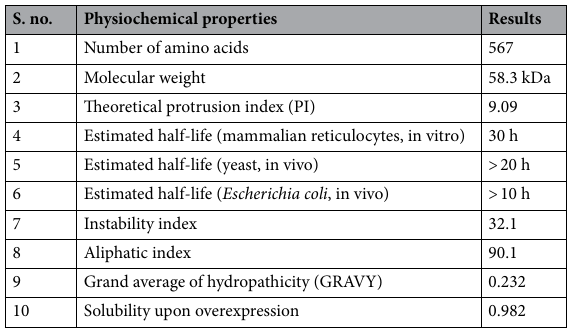
Table 4. Physiochemical properties of the subunit multi-epitopes vaccine construct.